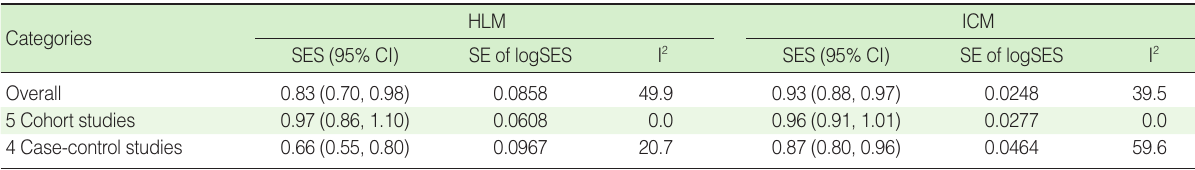
SE of logES, standard error of logarithm effect